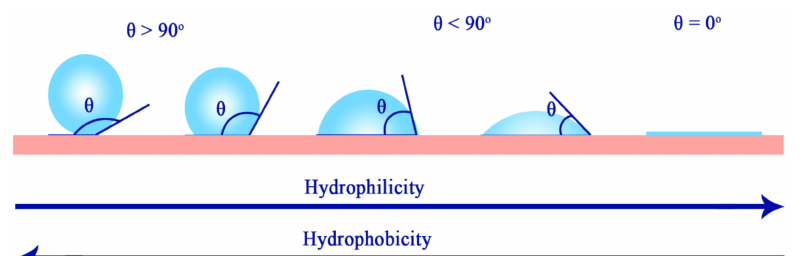
Figure 3. Schematic representation of the contact angle ( θ ) of a water droplet with a solid surface. The contact angle is typically used as a measurement of the wettability index of a surface, in which a contact angle of 0 ◦ indicates superhydrophilicity, less than 90 ◦ indicates hydrophilicity, greater than 90 ◦ indicates hydrophobicity, and greater than 150 ◦ indicates